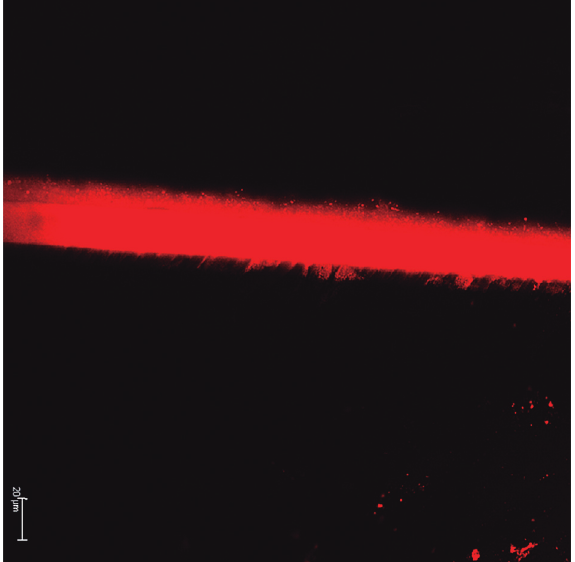
Figure 5a- Interface aspect of bonding system to enamel surface eroded by regular Coke (RC). Tags are not easily observed. Hybrid layer is based on superficial tags formation